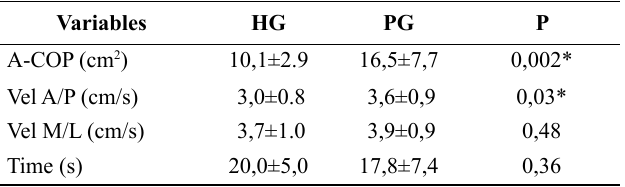
Table 2. Postural sway variables in healthy older adults (HG) and Parkinson’s disease individuals